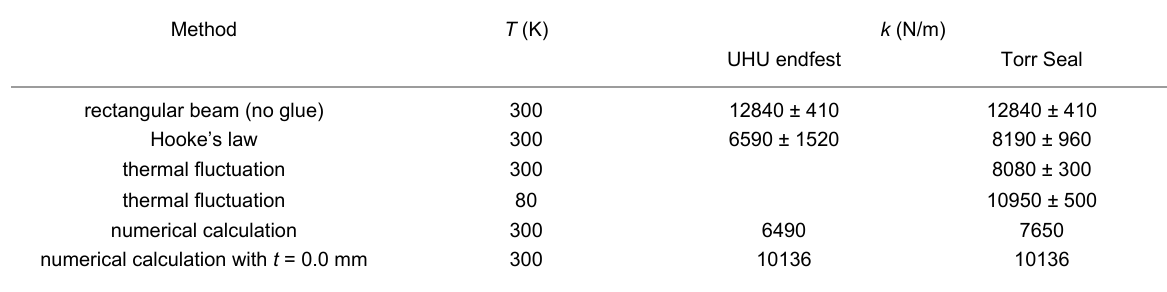
Table 4: Comparison of the different evaluation